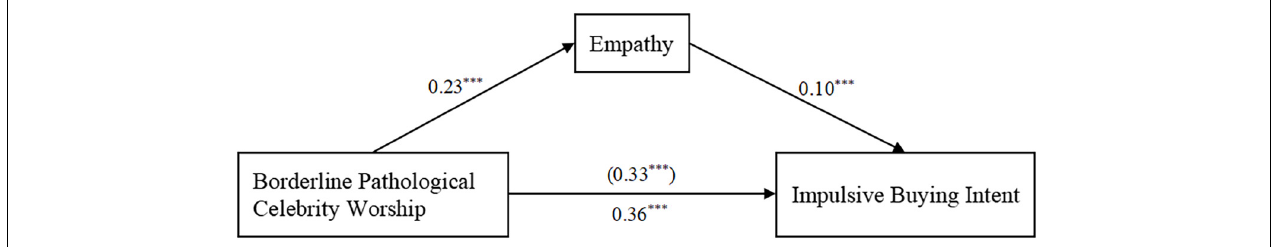
FIGURE 2 | Test of the mediating effect of empathy in the association between borderline pathological celebrity worship and impulsive buying intent. The numbers are standardized regression coefficients. Paths between controlled variable (age) and each of the variables in the model are not displayed, ∗∗∗ p < 0.001.